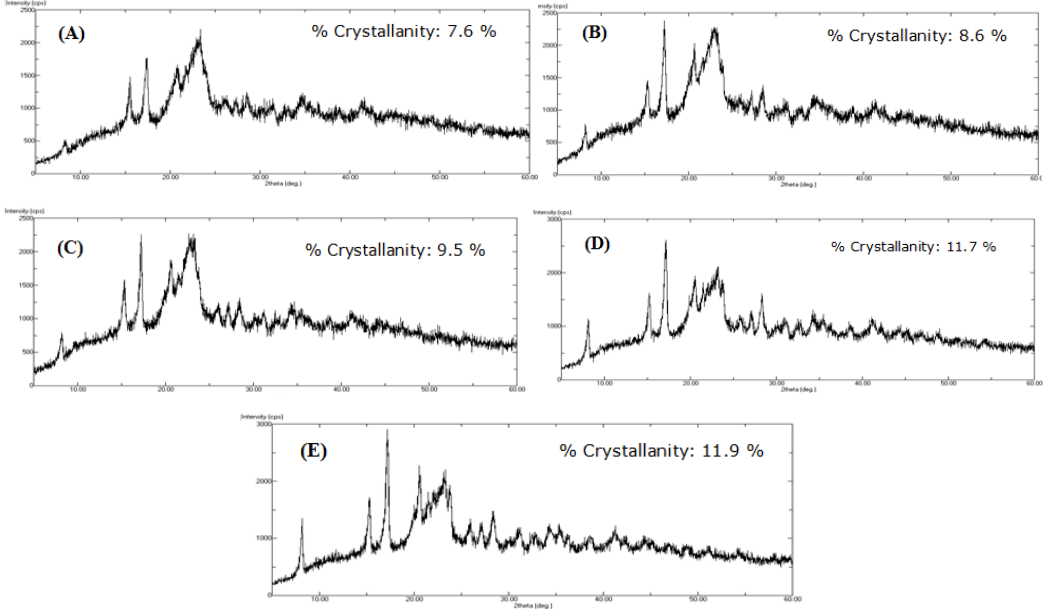
Figure 4. X-ray diffractograms of G2 (A), G4 (B), G5 (C), G6 (D) and G7 (E).